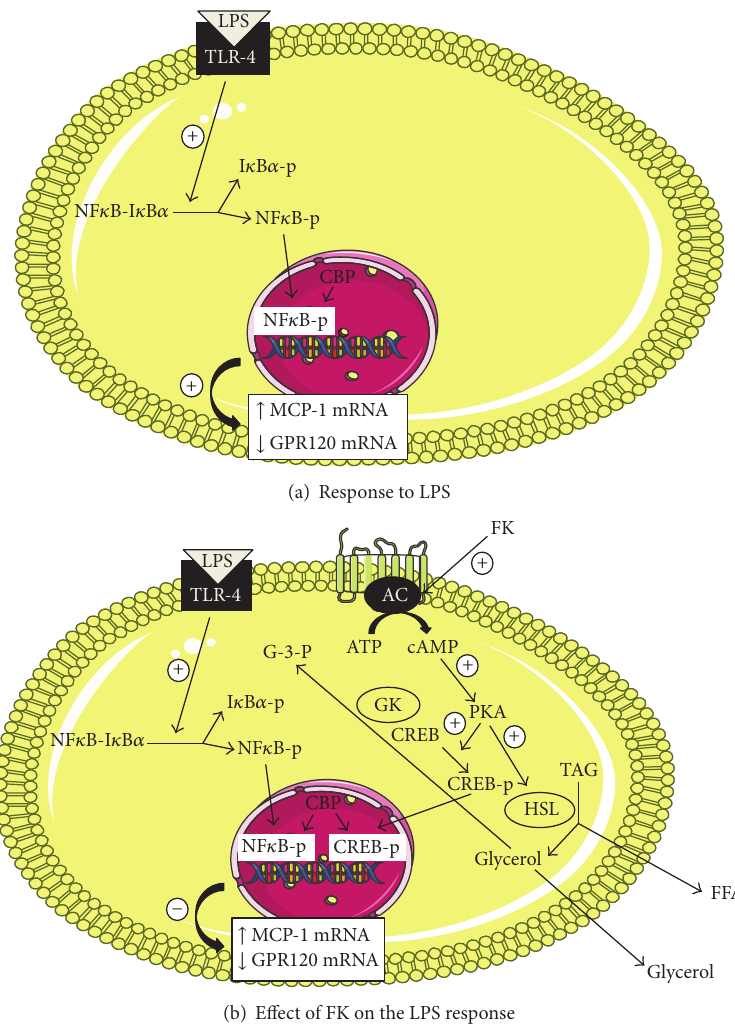
Figure 8: Data summary. (a) When adipocytes are stimulated with LPS, GPR120 mRNA levels are decreased, while MCP-1 mRNA and protein levels are upregulated via TLR-4 signaling pathway and NF 𝜅 B activation. (b) When adipocytes are treated with LPS in the presence of FK, the LPS-induced effects on both MCP-1 and GPR120 are inhibited via PKA and CREB activation necessitating CBP binding. AC: adenylylcyclase;ATP:adenosinetriphosphate;cAMP:cyclicadenosinemonophosphate;CBP:CREB-bindingprotein;CREB:cAMPresponse element-binding protein; FFA: free fatty acids; FK: Forskolin; G-3-P: glycerol-3-phosphate; GK: glycerol kinase; GPR120: G-protein coupled receptor 120; H: catecholamines or hormones; HSL: hormone sensitive lipase; I 𝜅 B 𝛼 : inhibitor of kappa B; LPS: lipopolysaccharide; MCP-1: monocyte chemotactic protein-1; NF 𝜅 B: nuclear factor- 𝜅 B; p: phosphorylated; PKA: protein kinase A; TAG: triacylglycerol; TLR-4: Toll-like receptor